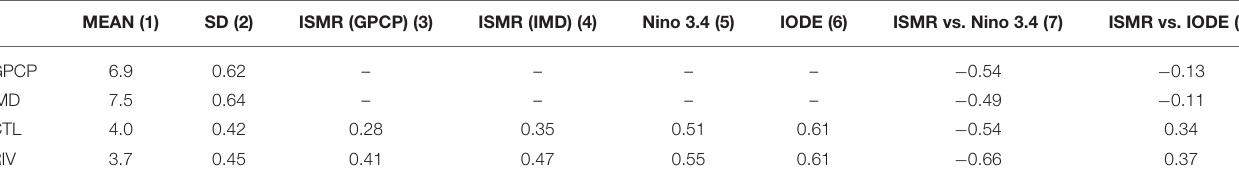
TABLE 2 | The table lists the mean and standard deviation of All-India Summer Monsoon rainfall (AISMR) averaged over land region (column 1–2), the model skill defined as the anomaly correlation coefficient between the observed and simulated parameter, for AISMR (column 3 & 4), Nino 3.4 index (column 5) and the Indian Ocean Dipole’s east (IODE) pole index (column 6), and the teleconnections between AISMR and Nino 3.4 index (column 7) and AISMR and IODE index (column